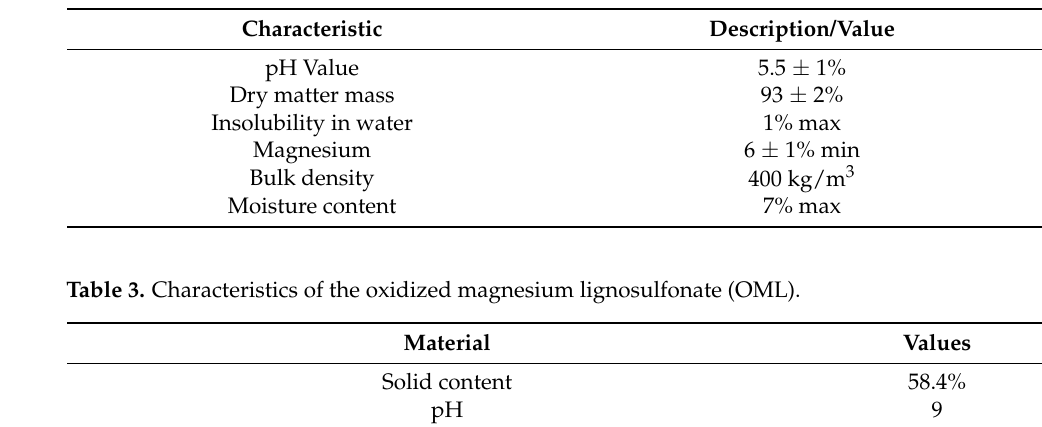
Table 2. Characteristics of the Magnesium Lignosulfonate LIGNEX MG F.